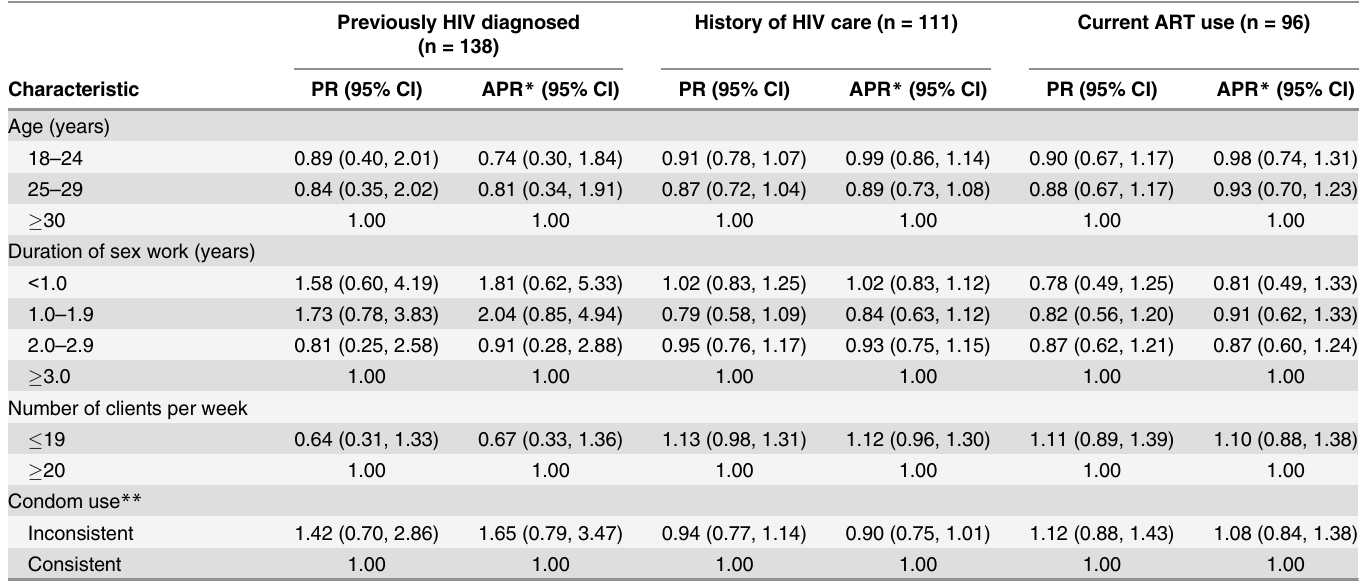
Table 3. Associations of demographic and transmission risk behaviors with HIV care continuum outcomes (previously HIV diagnosed, history of HIV care, and current ART use) among HIV-infected female sex workers in Lilongwe,